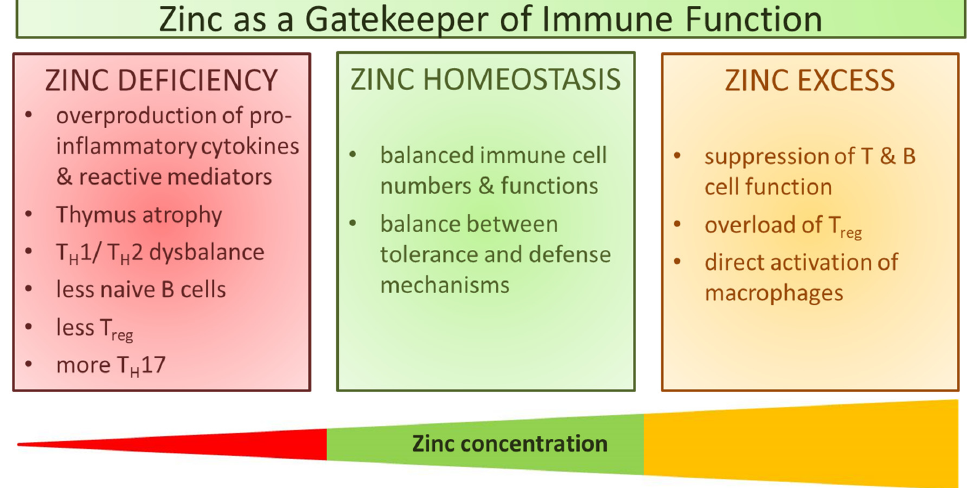
Figure 5. Influence of zinc status on the overall immune function. Adequate zinc homeostasis is essential for a well-functioning immune system. Zinc deficiency as well as zinc excess lead to malfunction of the adaptive and innate immune system, eventually resulting in the development of numerous immune diseases.